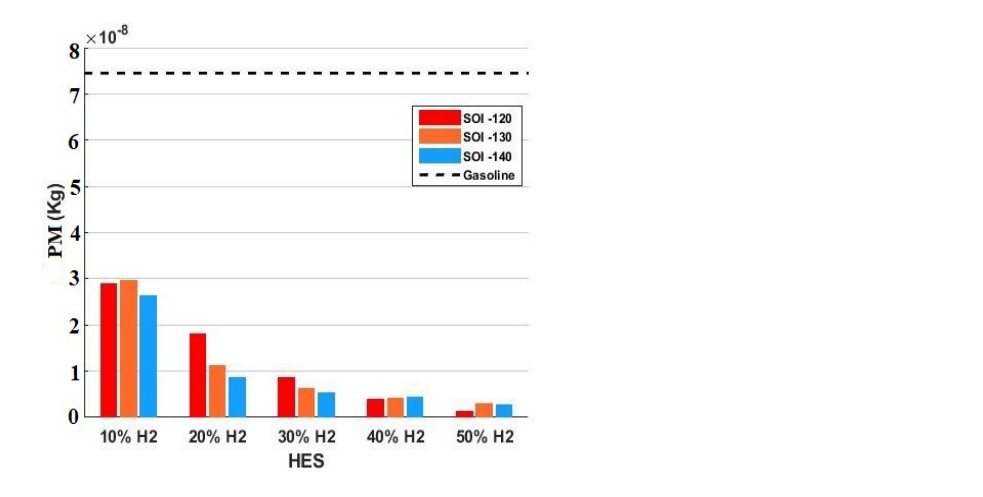
Figure 15. Effects of HES on CO, NO X and PM emissions for start of injection (SOI) − 120 CAD aTDC at exhaust valve open (EVO).